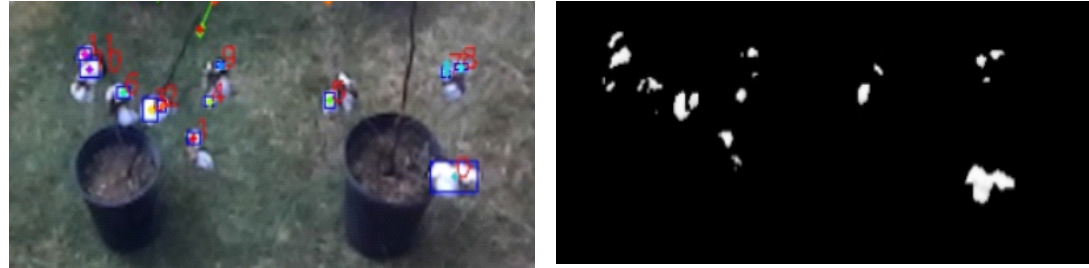
Figure 12. Comparison of the image frames when the rover was stationary. The y-axis is the camera measurements, while the x-axis is the manual measurements. the first and second frames were taken consecutively to compare the depth estimation.